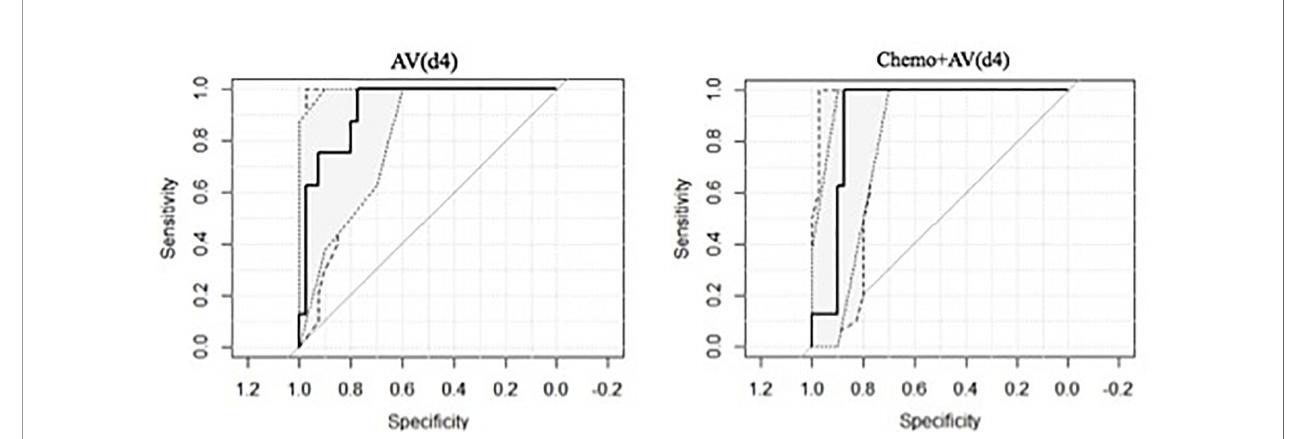
FIGURE 2 | ROC curves of the model elaborated.